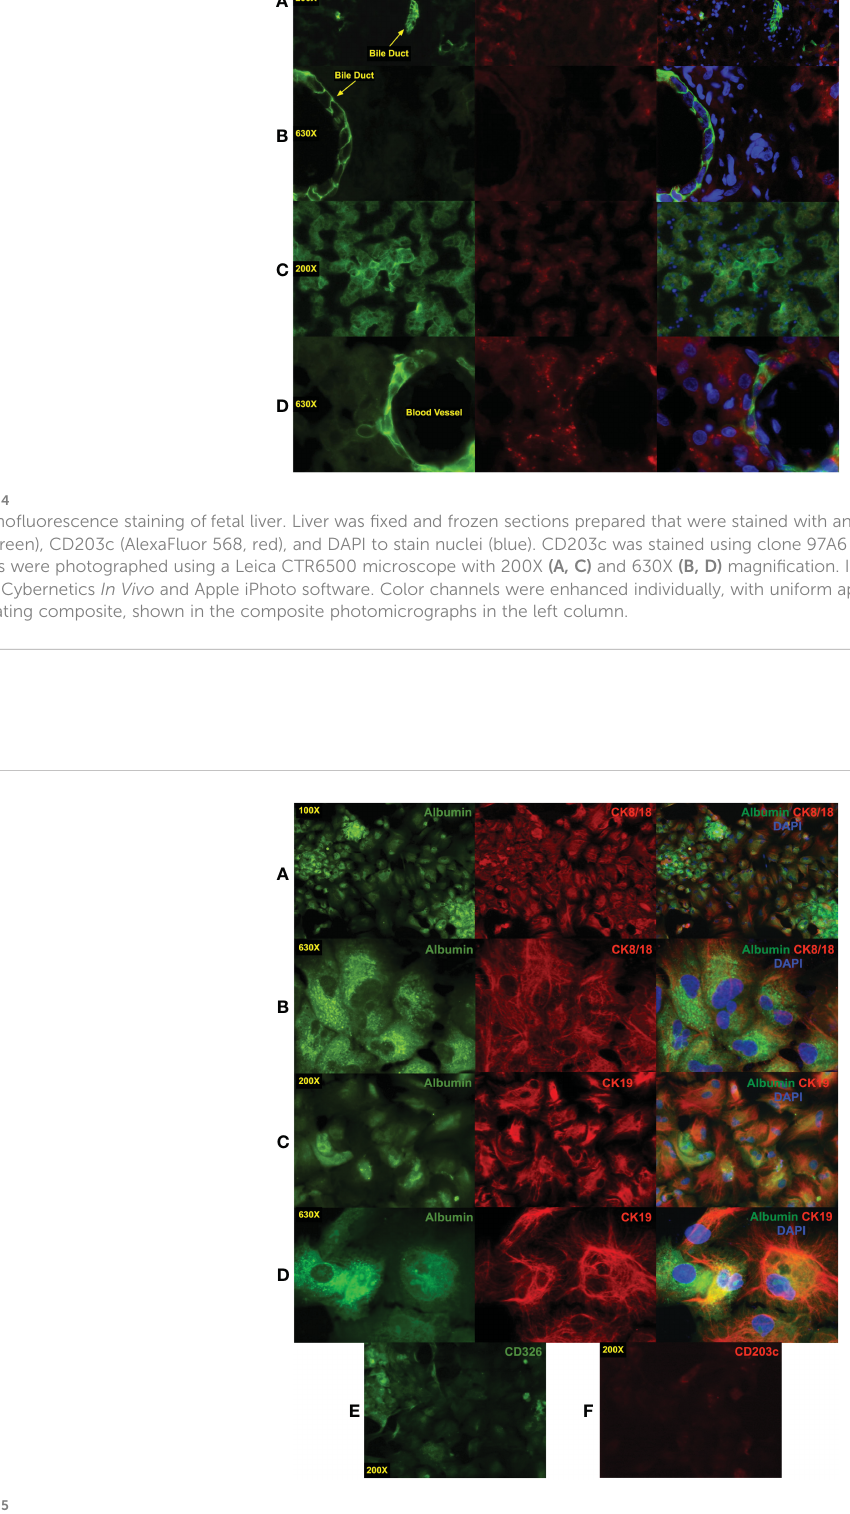
FIGURE 5 Immuno fl uorescence staining of cultured CD203c + CD326 ++ cells. CD203c + CD326 ++ cells were isolated by cell sorting and cultured for 11 days in William ’ s E medium. The cultured cells have a typical morphology of hepatocytes in tissue culture that express albumin and cytokeratin (CK)8/18 (A) . Multinucleated cells are evident at high magni fi cation (630X, (B) . Coexpression of the hepatoblast markers albumin and CK19 was also observed (C, D) as well as more polarized expression of these markers suggesting differentiation into albumin + hepatocytes and CK19 + cholangiocytes. Low levels of CD326 (E) and a near absence of CD203c (F) expression were observed on the cultured cells. Photomicrographs were prepared as described in Figure